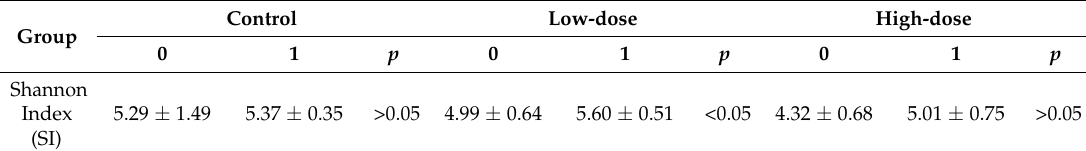
Table 3. Shannon Index of three groups before and after intervention.